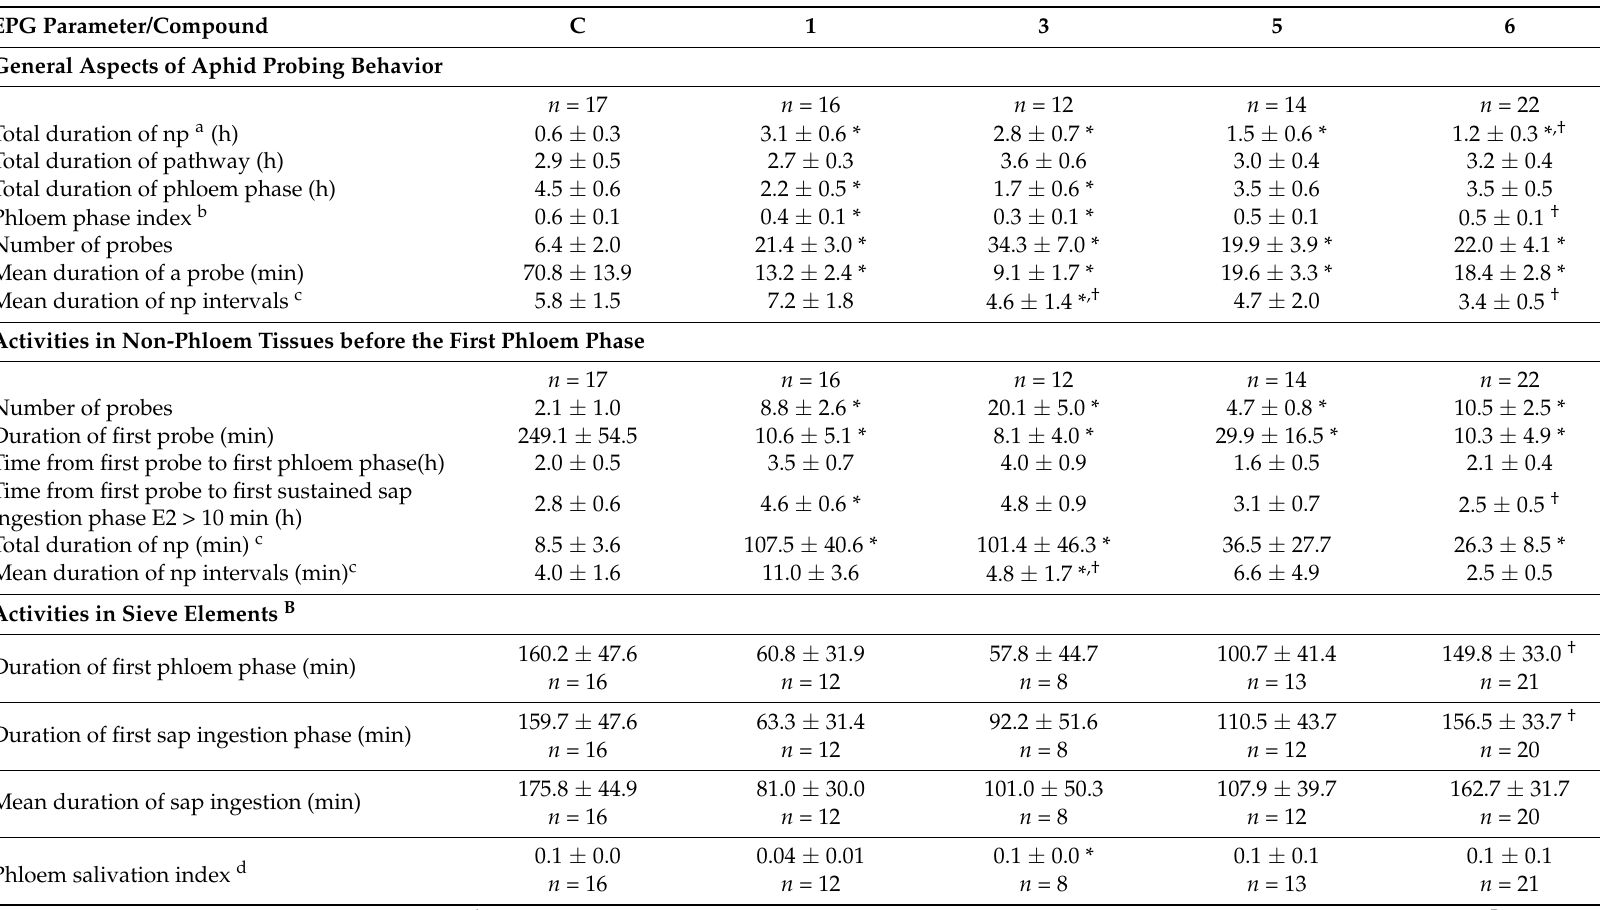
Table 1. Probing behavior (EPG parameters) of Myzus persicae on Brassica rapa subsp. pekinensis leaves treated with cis -jasmone ( 1 ) and its derivatives: (+)-( R )-4-hydroxyjasmone ( 3 ), 7,8-epoxyjasmone ( 5 ), and 4-hydroxy-7,8-epoxyjasmone ( 6 ) A . The same plant species was used to maintain the aphid stock